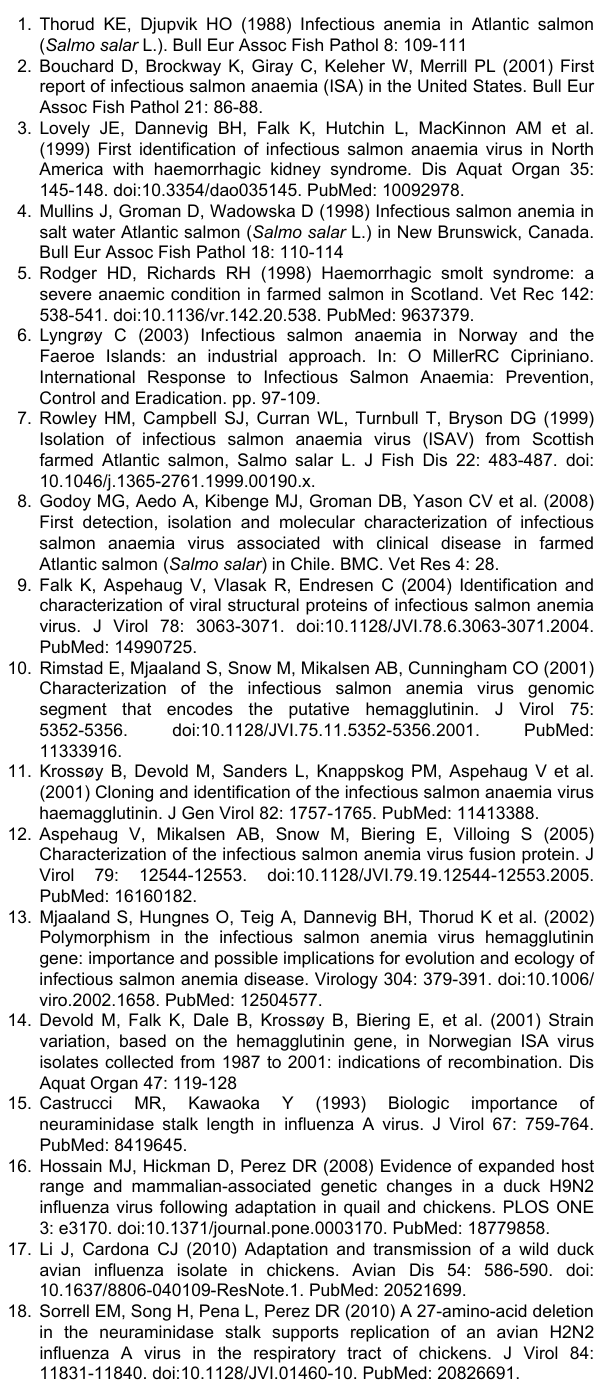
Table S3. Type, number and prevalence of mutations present in ≥ 0.05% of reads, deletions and insertions as detected by UDPS of F